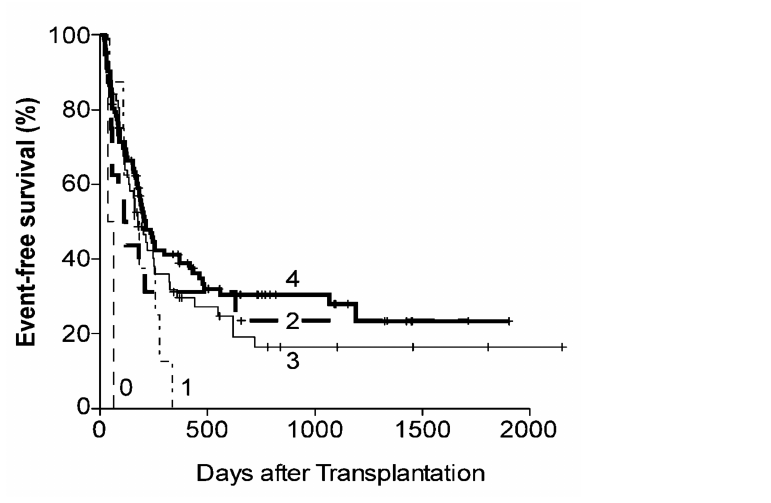
Figure 5. Event-free survival (EFS) of patients undergoing nonmyeloablative haploiden- tical stem cell transplantation with post-transplantation cyclophosphamide according to number of nismatched HLA-antigens in any direction (GVH or